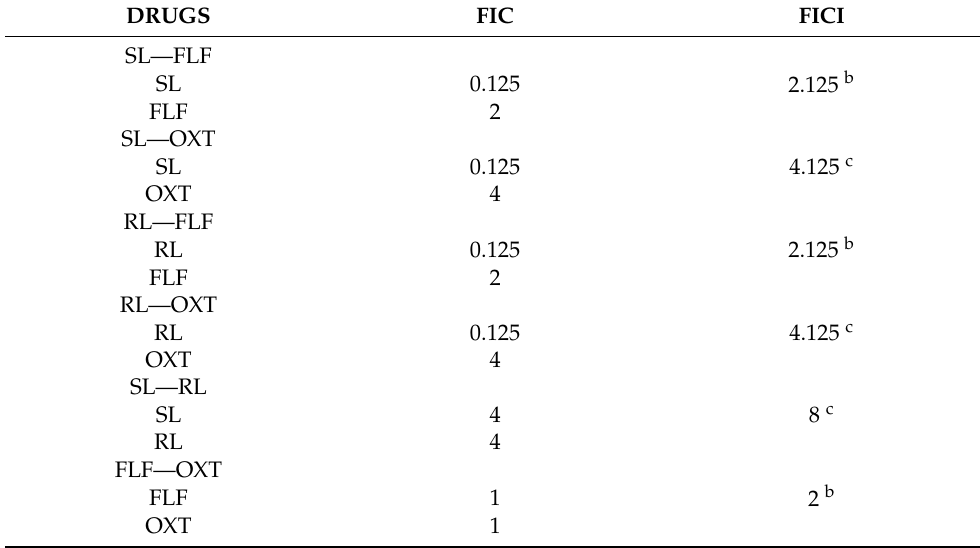
Table 2. Fractional inhibitory concentration (FIC) and fractional inhibitory concentration index (FICI) of phytochemicals S-(+)-limonene (SL) and R-(+)-limonene (RL) in association with different combinations of the antimicrobials florfenicol (FLF) and oxytetracycline (OXT) against Aeromonas hydrophila MF 372510.